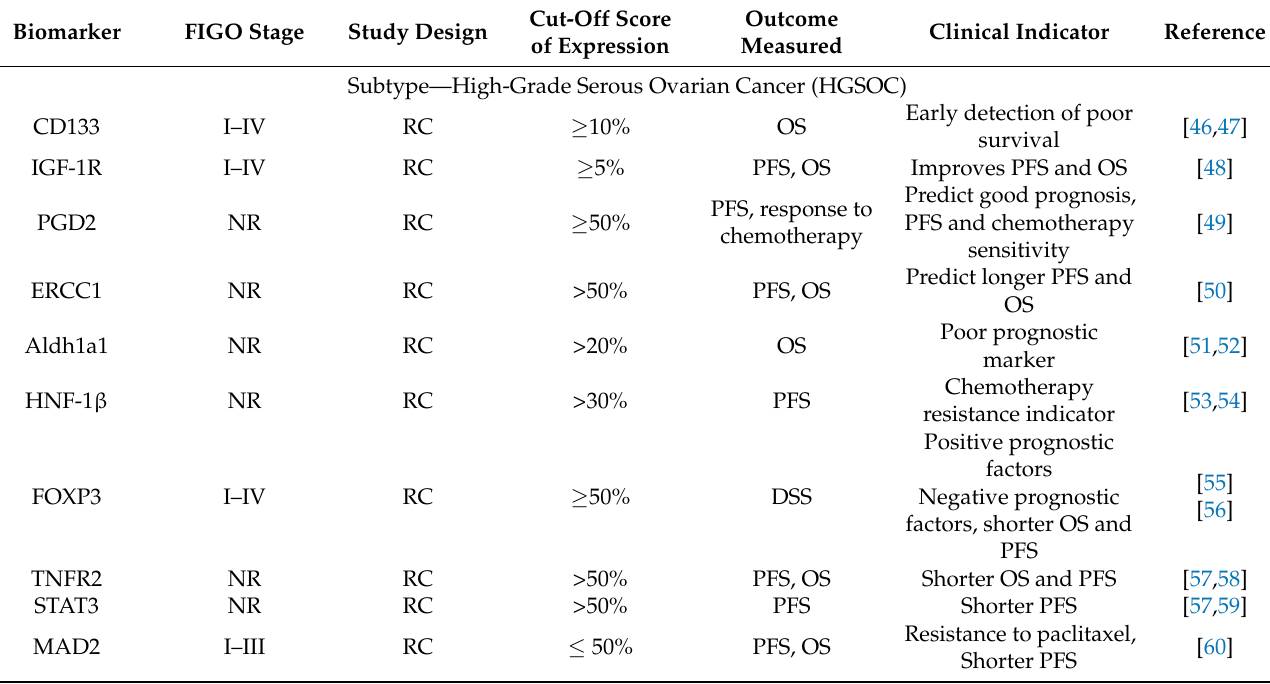
Abbreviations: EOC, Epithelial Ovarian Cancer; FIGO, International Federation of Gynecology and Obstetrics; IHC, Immunohistochemistry; RC, retrospective cohort; OS, overall survival; PFS, progression-free survival; NR, not reported. Table 2. Summary of IHC biomarkers associated with chemoresistance and prognosis in HGSOC and